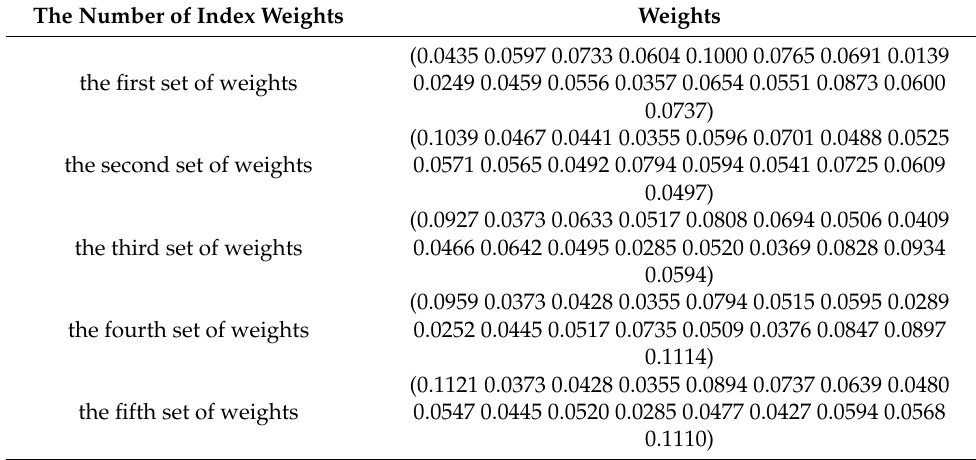
Table 3. Indicator weights based on